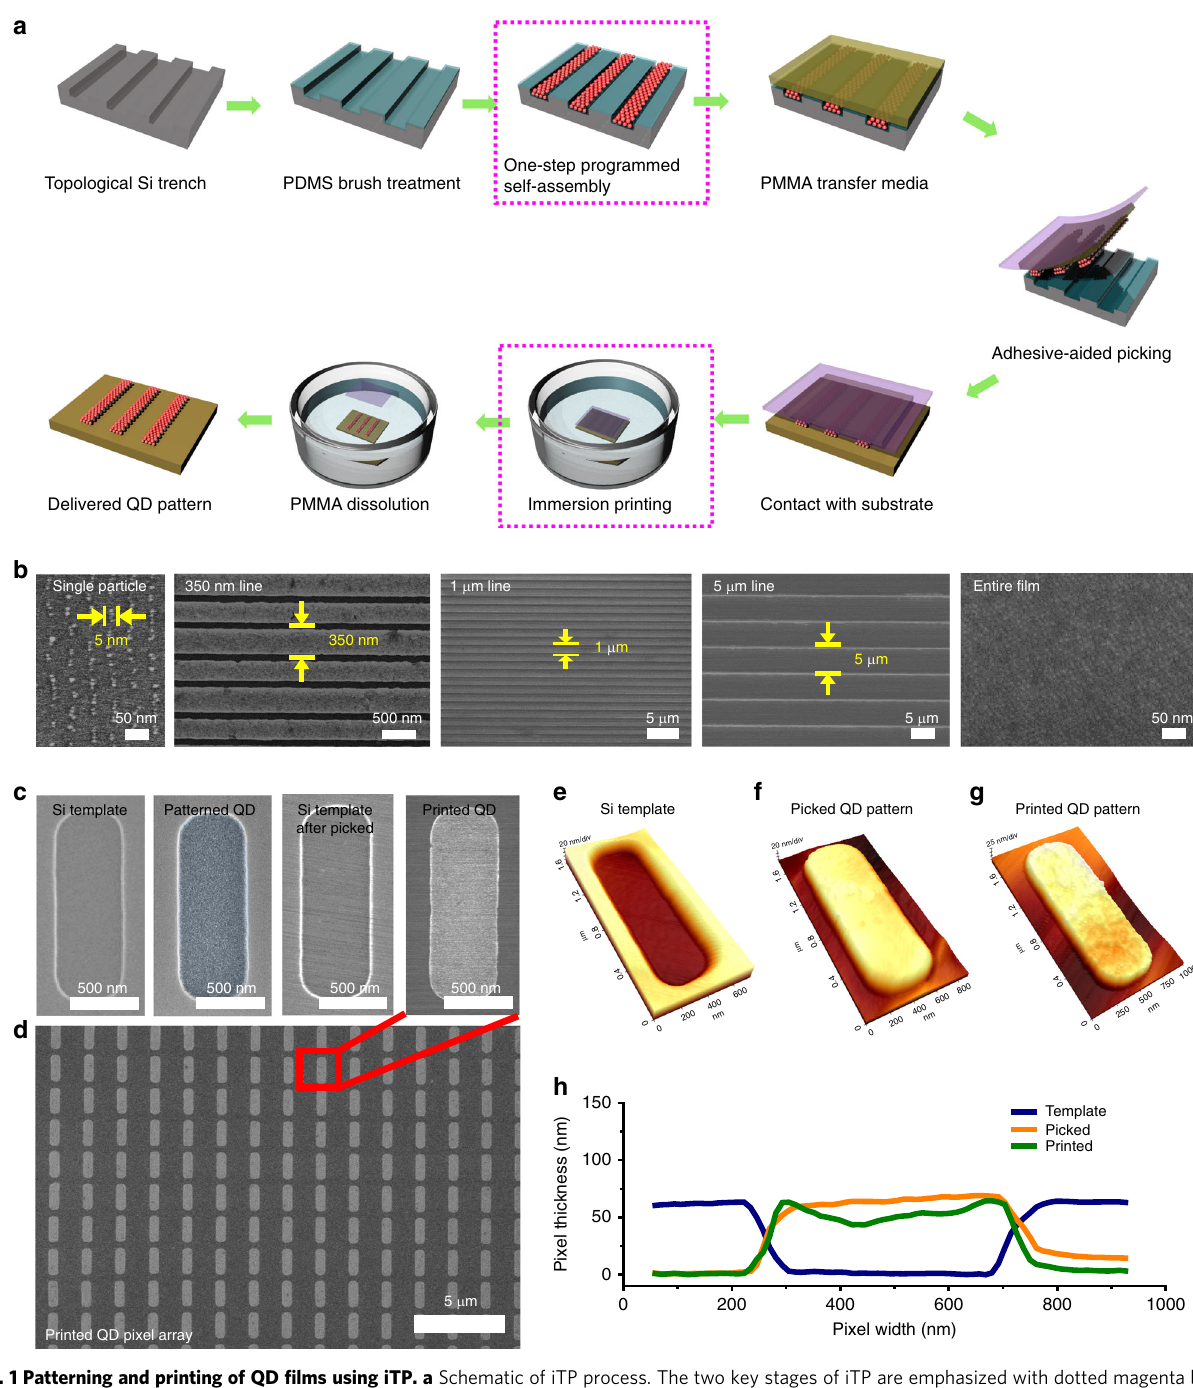
Fig. 1 Patterning and printing of QD fi lms using iTP. a Schematic of iTP process. The two key stages of iTP are emphasized with dotted magenta boxes. b SEM images of printed QD arrays in different resolutions: single-particle, 350 nm, 1 µ m, 5 µ m, and entire fi lm (from left to right). c SEM images of topographic trench template fabricated on Si substrate, patterned QD fi lm in trench domain, the Si template after QDs are picked, and printed QD pattern (from left to right). d SEM image of printed QD pixel array (500 nm pixel width). Topographic AFM images of the Si template ( e ), picked ( f ), and printed ( g ) QD pixel. h AFM thickness pro fi le plot of the Si template, picked and printed QD